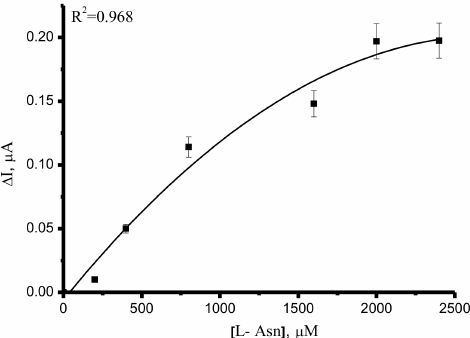
Figure 5. The dependence of the difference in the asparaginase oxidation current ∆ I = Ienz − I (enz + Asn) vs. L-Asn concentration as an electrochemical equivalent of the Michaelis–Menten plot. The values are the means from at least 3 experiments ±